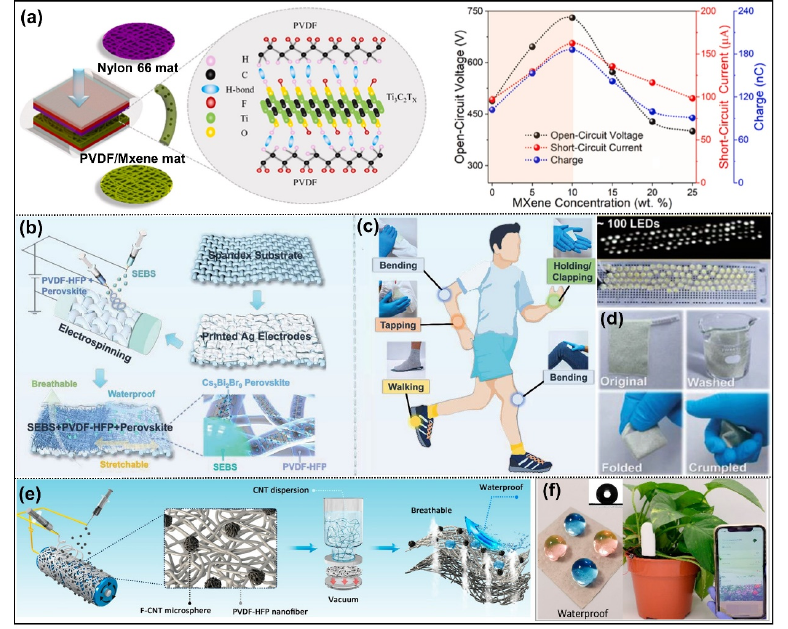
Figure 6. Nanofiber based triboelectric materials applied for energy harvesting prepared by electro ‐ spinning. ( a ) The structure of PVDF/Mxene nanofiber for TENG. Reprinted with permission from